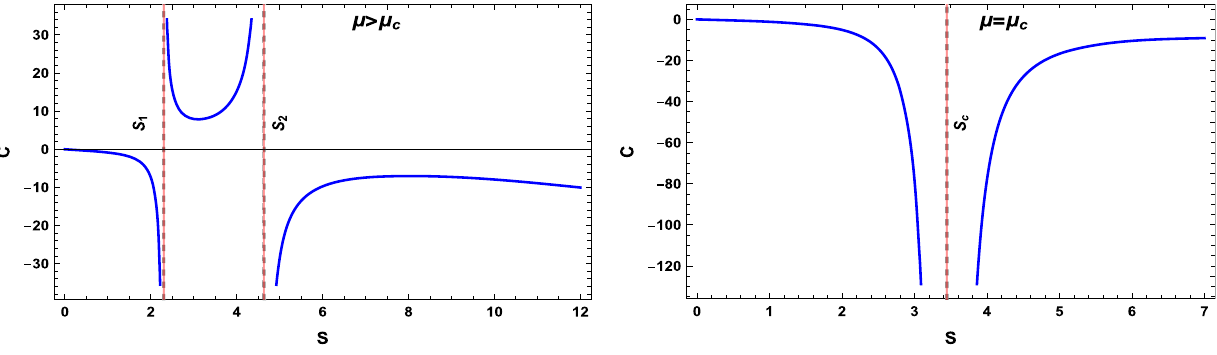
Fig. 4 Grand canonical ensemble: the heat capacity C μ versus S of neutral BH for: μ > μ c (left) and μ = μ c (right), the dashed lines correspond to the divergency points of C μ ; red lines correspond to critical points. We have set: c = 1 , α = 1 and β =